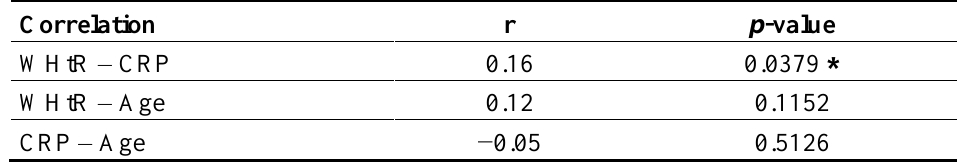
Table 2. Correlation between WHtR, CRP, alcohol consumption and the participants’